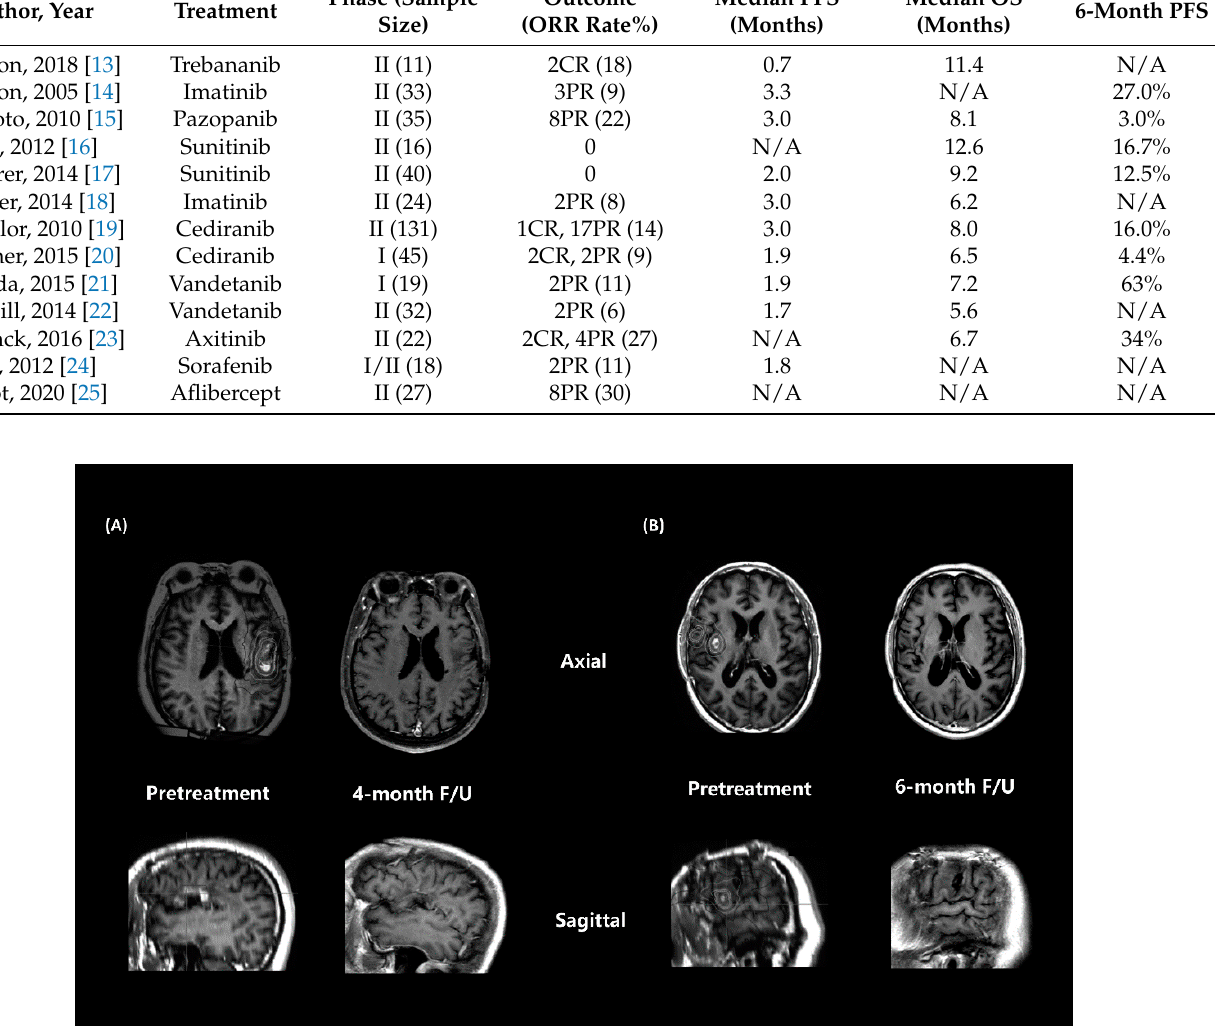
Figure 2. Contrast-enhanced MRI T1 of responses to HSRT and anlotinib, including ( A ) patient case 1 and ( B ) patient case 4, who achieved a complete response.